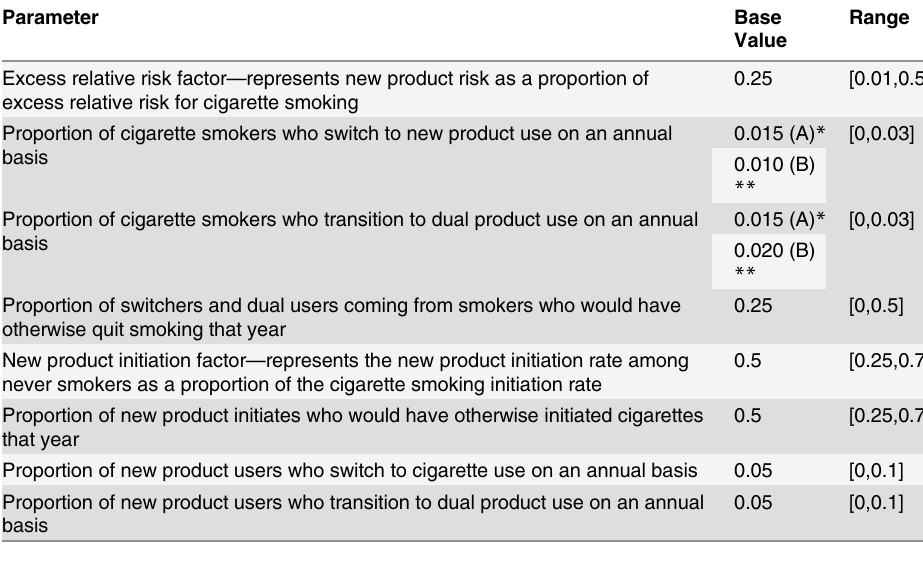
Table 1. Hypothetical Scenario Input Parameters and